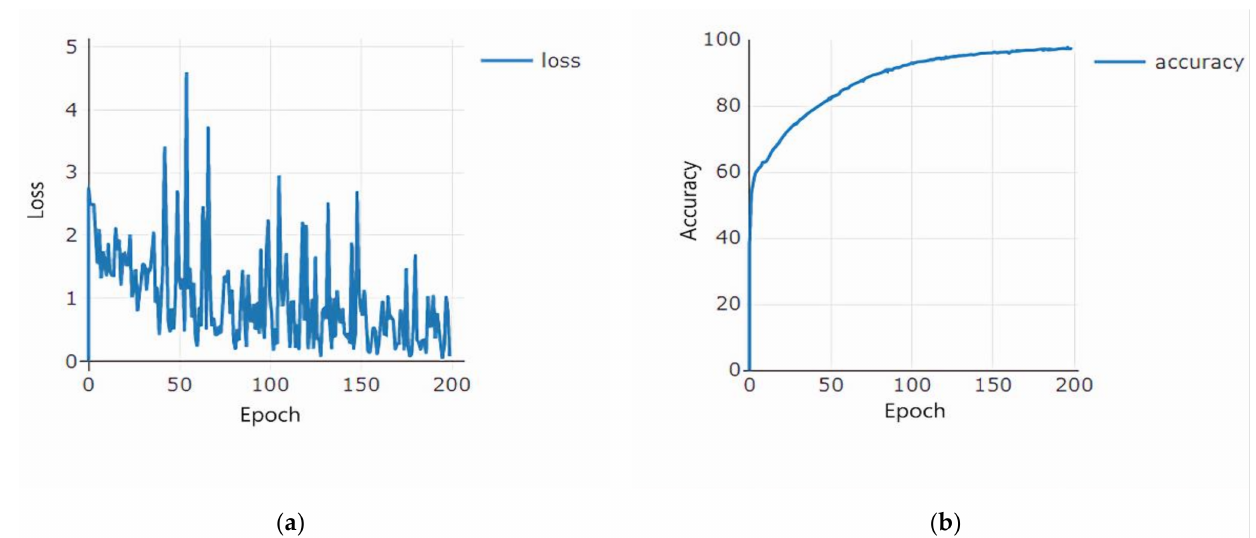
Figure 12. Performance of the second data set. ( a ) loss (%), ( b ) accuracy (%).